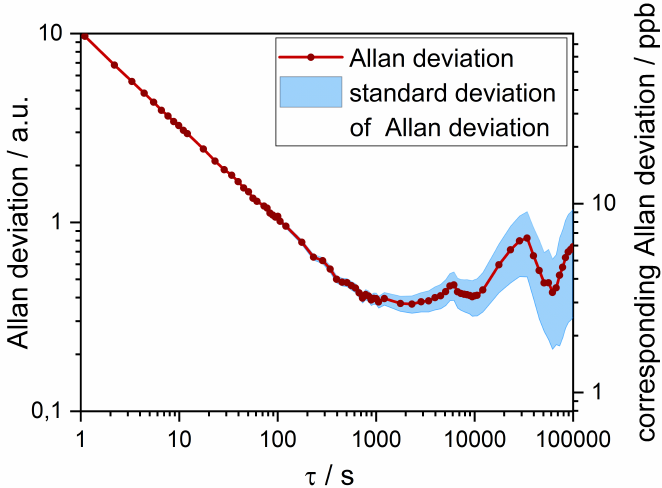
Figure 8. Calculated Allan deviation of the ambient air signal over a measuring time of 72 h. The left axis shows the Allan deviation in counts. On the right axis it is converted into ppb using the sensors sensitivity of 125 counts per